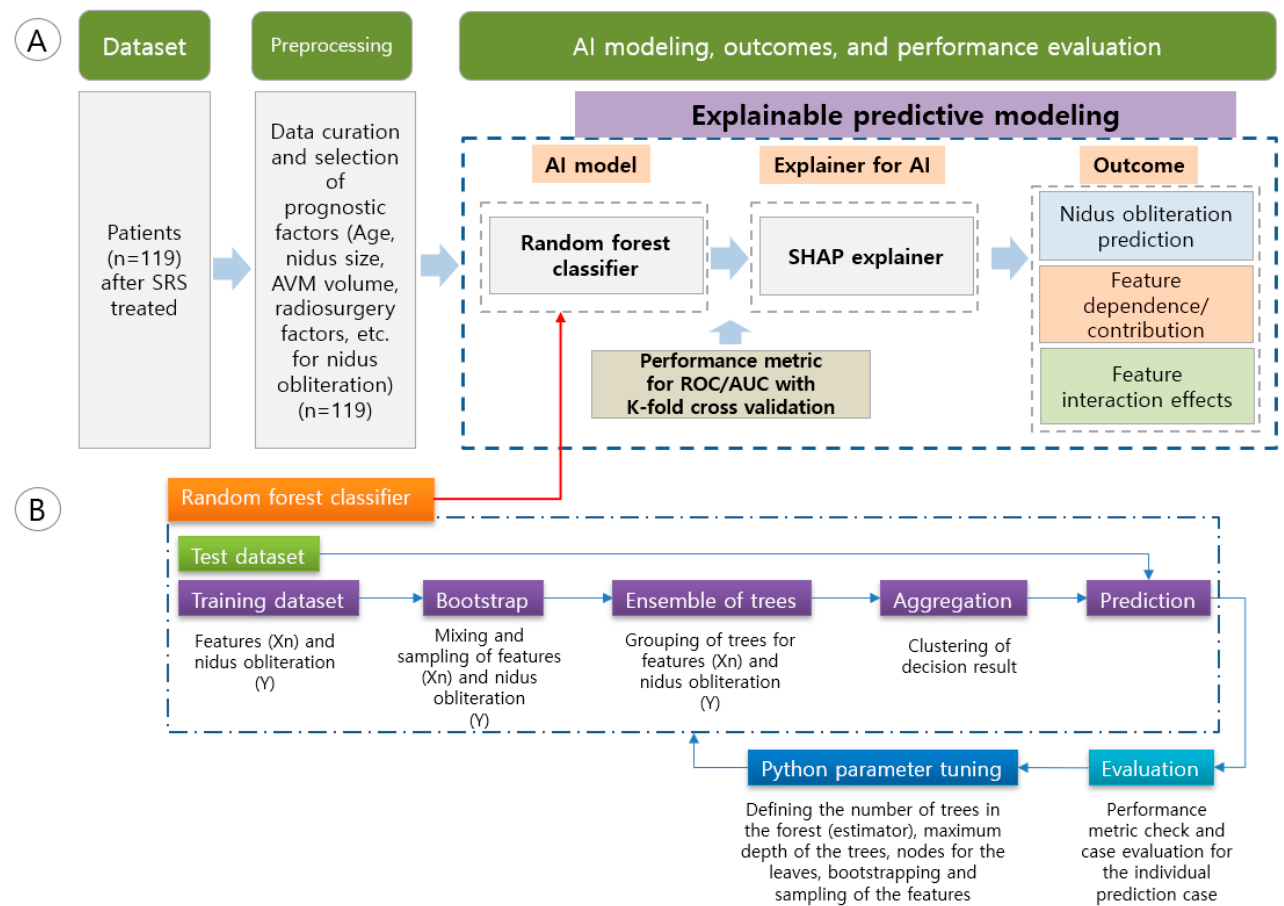
Figure 1. Diagram for nidus obliteration prediction and feature importance analysis. ( A ) Entire block diagram for the input, modeling, and output process including evaluation method. ( B ) Specific pipeline for the random forest classi fi er modeling process for this study.